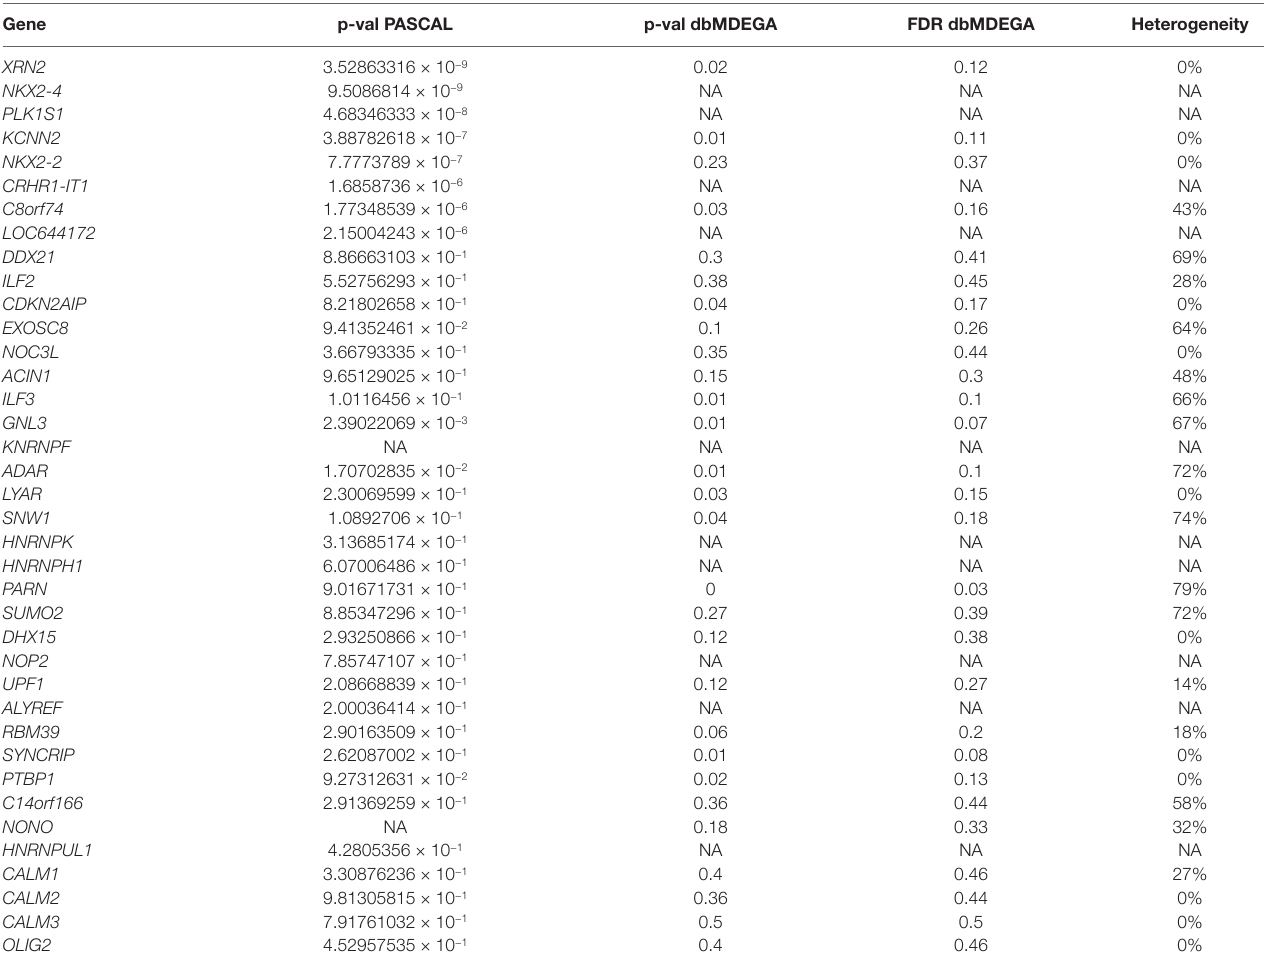
TABLE 6 | PASCAL associated genes and interactors. p-values from PASCAL and dbMDEGA meta-analysis are shown for each gene. p-values from dbMDEGA were computed using the p-value method. Heterogeneity values (I 2 ) are also shown. (NA = the gene is not in dbMDEGA).